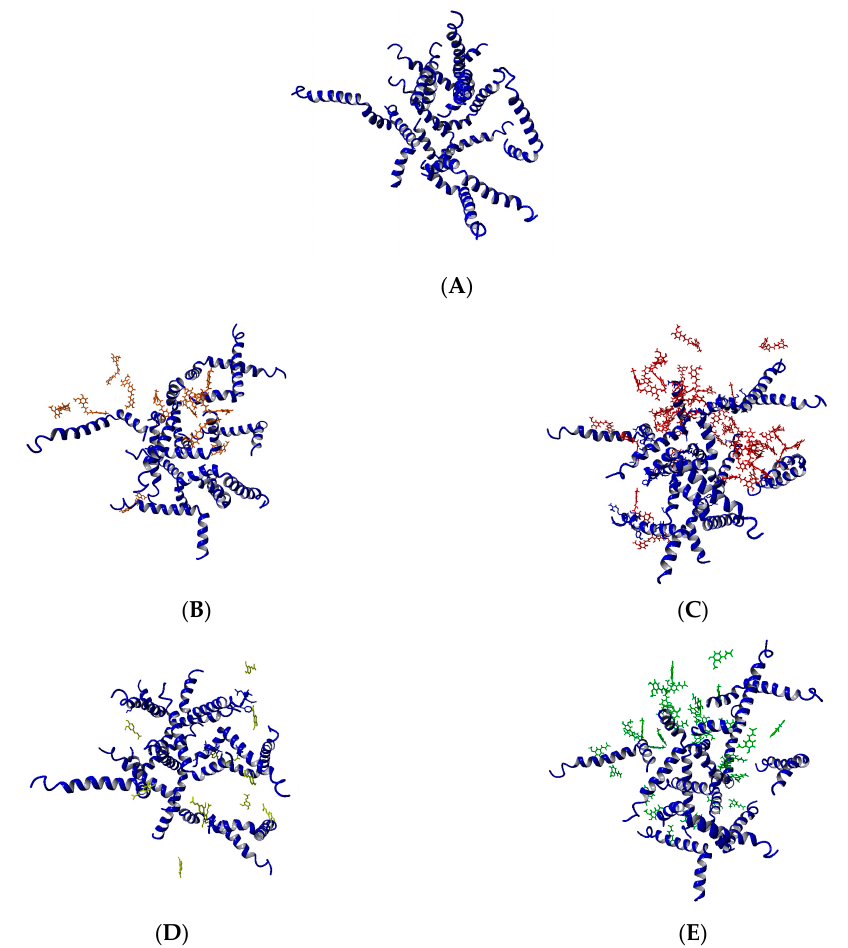
Figure 2. Modeled systems in the present study: ( A ) 12 A β monomers; ( B ) 12 A β monomers and 12 CU molecules; ( C ) 12 A β monomers and 36 CU molecules; ( D ) 12 A β monomers and 12 FA anions; ( E ) 12 A β monomers and 36 FA